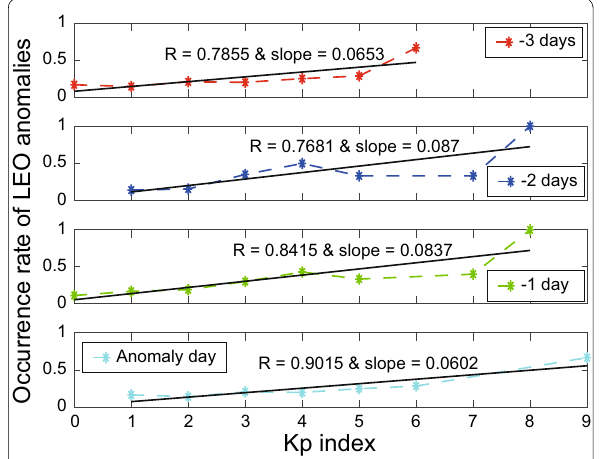
Fig. 5 LEO satellite anomaly occurrence rates for (from top) 3 days (panel 1), 2 days (panel 2), and 1 day (panel 3) prior to the anomaly day and on the anomaly day (panel